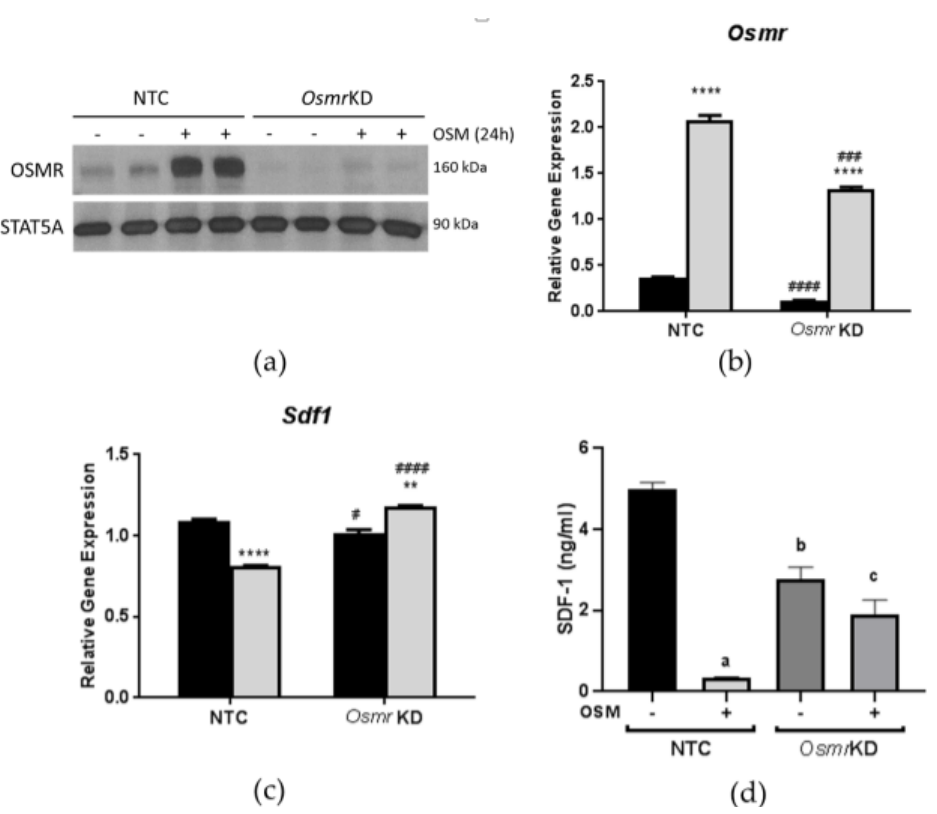
Figure 3. Oncostatin M receptor (OSMR) is required for Sdf1 suppression in adipocytes. Fully- differentiated 3T3-L1 adipocytes were transfected with si Osmr or a non-targeted control siRNA; 48 h after transfection, cells were exposed to 0.5 nM OSM for 24 h. Gene expression was then analyzed and expression levels were normalized to a numerical average of three housekeeping genes ( Ppia , Ubb , and Nono ). ( a , b ) Efficiency of OSMR knockdown. ( c ) The suppressive effect of OSM on Sdf1 expression is lost with OSMR silencing. ( d ) Effects of OSMR knockdown on SDF-1 secretion into culture media. In panels ( a , b ), black bars = vehicle-treated cells; gray bars = OSM-treated cells. KD = knockdown. ** p < 0.01 and **** p < 0.0001 vs. vehicle controls. # p < 0.05, ## p < 0.01, and #### p < 0.0001 vs. NTC. In panel ( d ), a = p < 0.001 vs. NTC; b = p < 0.01 vs. NTC; c = p < 0.05 vs. NTC + OSM. This experiment was performed